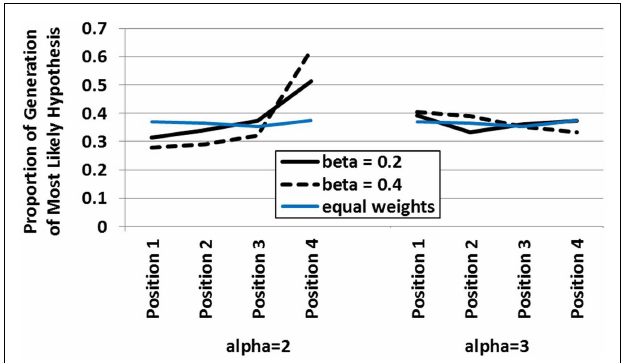
FIGURE 4 | Influence of data serial position on the hypothesis generation behavior of the dynamic HyGene model at two levels of alpha and beta (and the performance of an equal weighted model in blue). Data plotted represents the proportion of simulation runs on which the most likely hypothesis was